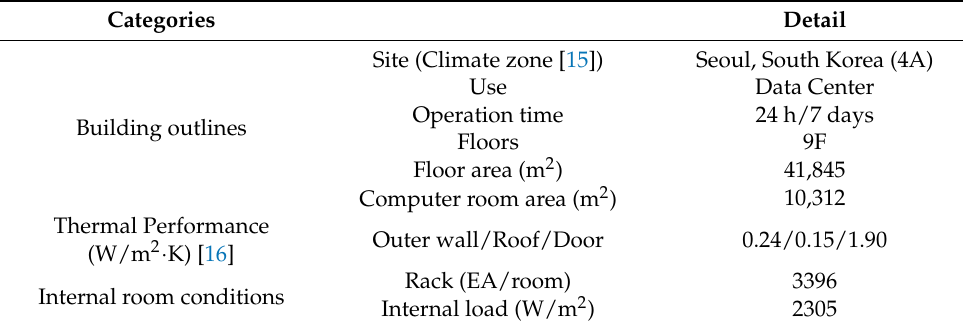
Table 1. Target building outlines.